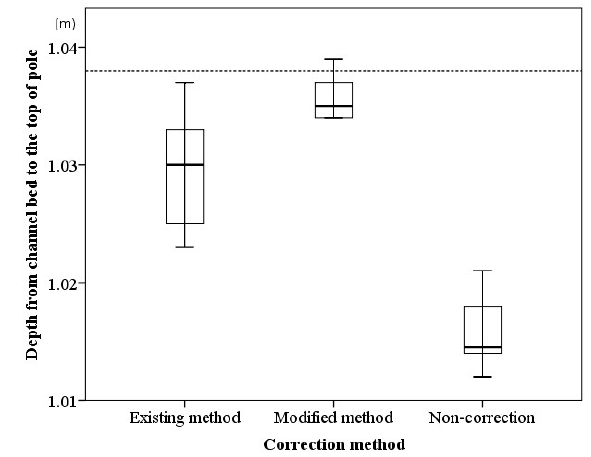
Figure 7. Comparison of depth from channel bed to the top of pole among correction methods. The broken line shows manually measured